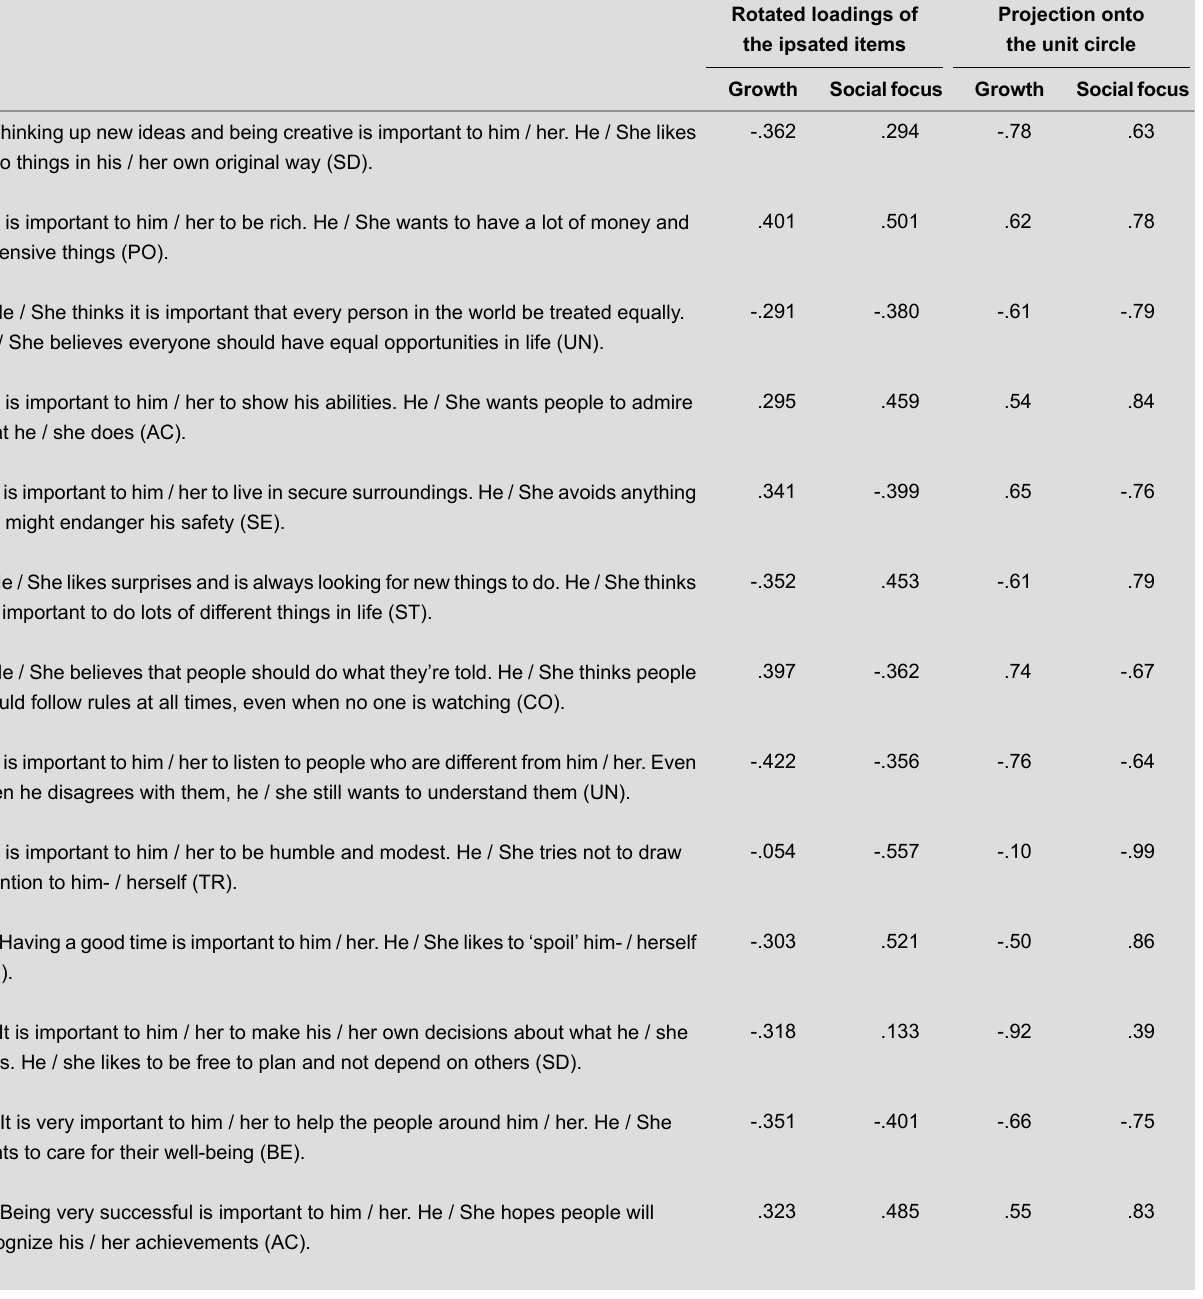
Loadings of ipsated items on the diagonal axes growth (vs. protection) and social (vs. personal) focus values and derived intersections of the unit circle used as restrictions in the CFA.